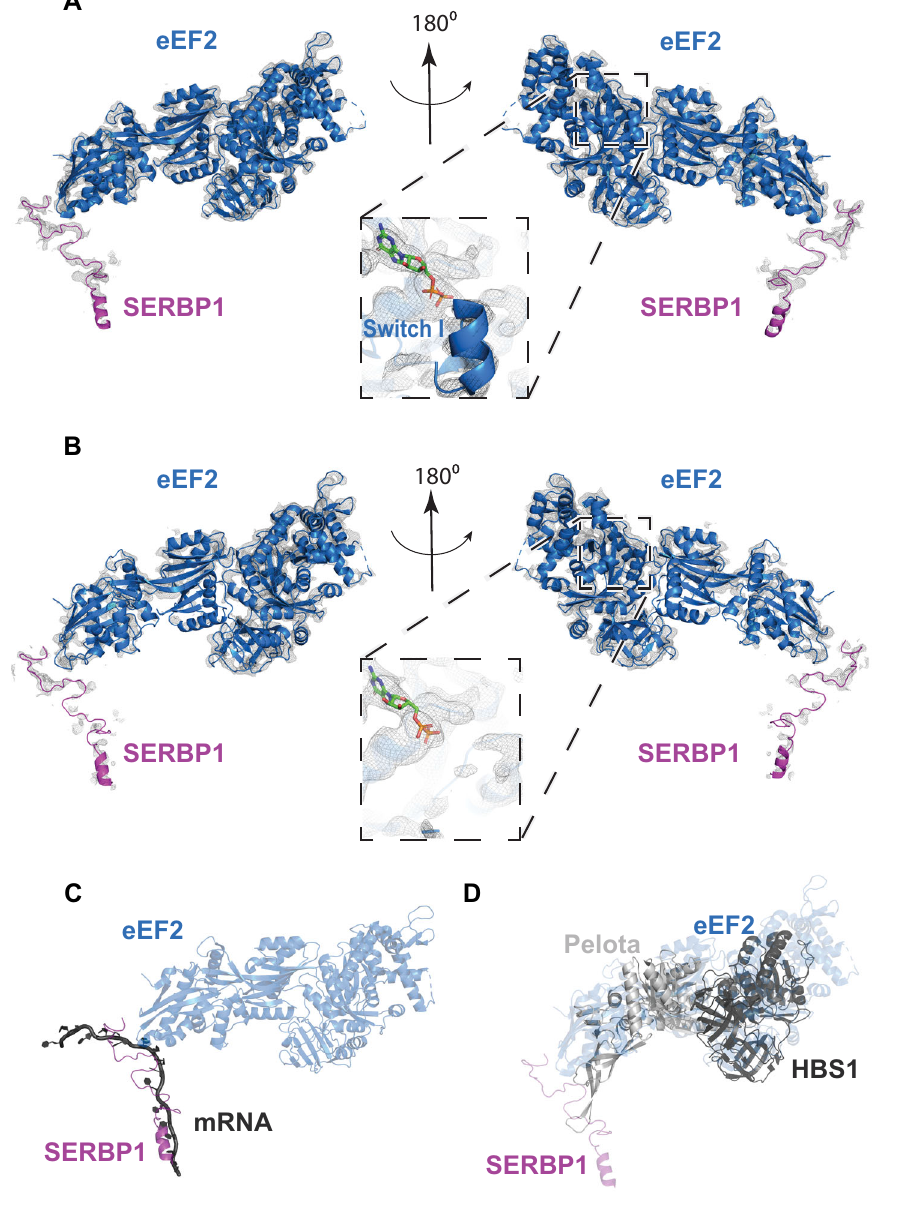
Fig. 6 Density maps of switch I, and overlays of SERBP1, and eEF2 with mRNA, and recycling factors. A View of eEF2 and SERBP1 of class I, and B class II. C For comparison on SERBP1 with a canonically bound mRNA, we aligned class I 28S rRNA to 28S rRNA from PDB ID 2Y0G. SERBP1 (purple) occupies the mRNA channel for the ribosome, thus excluding mRNA (dark gray) binding. D The overlay of class I with a recycling factor Hbs1/Pelota-bound ribosome (PDB ID 5LZX) illustrates that recycling factor Pelota and Hbs1-binding is mutually exclusive with bound eEF2/SERBP1. Class I 28S rRNA was aligned to 28S rRNA of the Hbs1/Pelota-bound